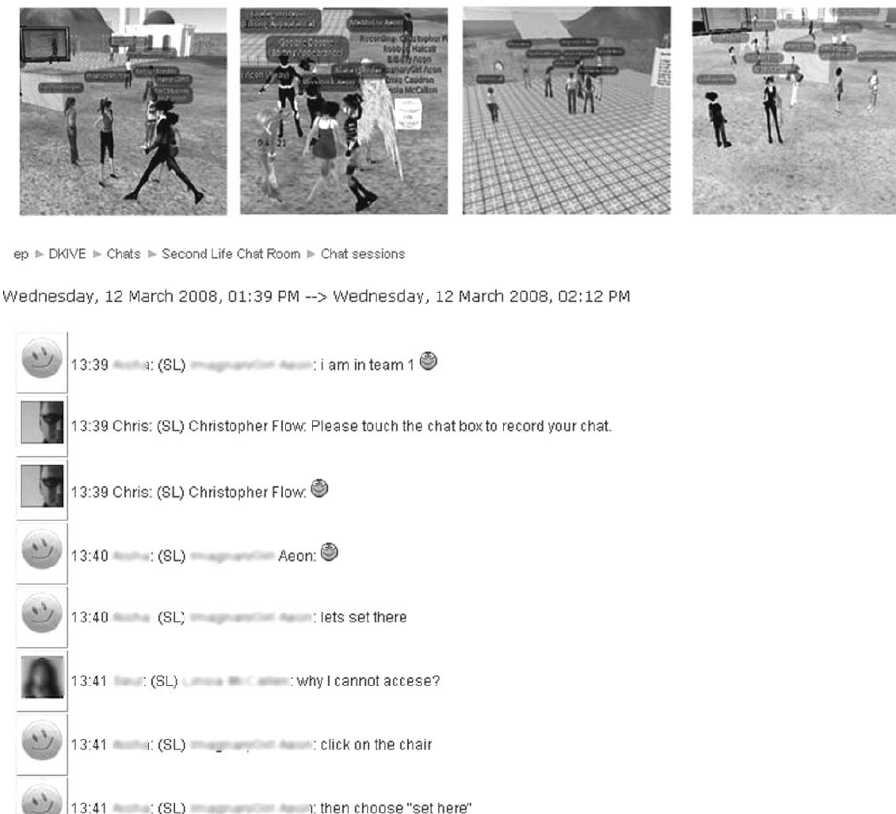
Figure 6. A Second Life chat archive in Moodle supports reflection on and review of class activi- ties – and links Moodle and Second Life identities of